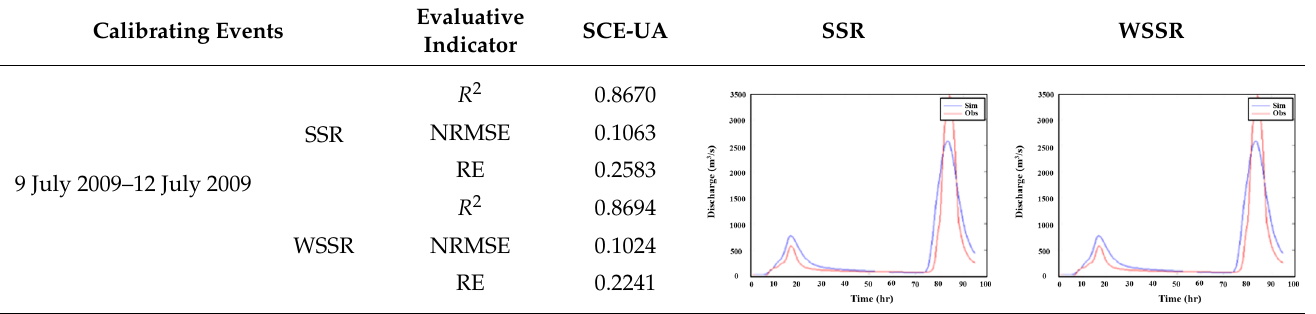
Table 2. Calibration of the model using objective functions.